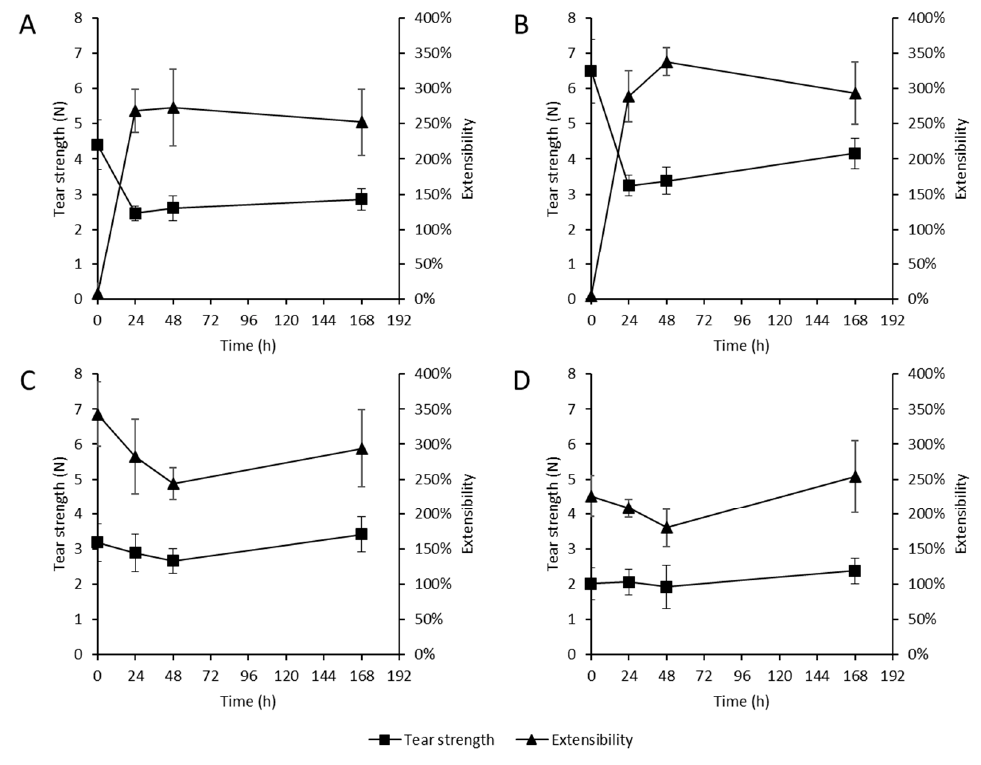
Figure 5. Stress at break (N) and extensibility of multifilament yarns over the time of storage at 40 °C and 75% r.h. (n = 10 +/ − SD). ( A ) 100.0% polyvinyl alcohol (PVA); ( B ) 99.0% PVA, 1.0% glycerol; ( C ) 95.5% PVA, 4.5% glycerol; ( D ) 90.0% PVA, 10.0% glycerol.